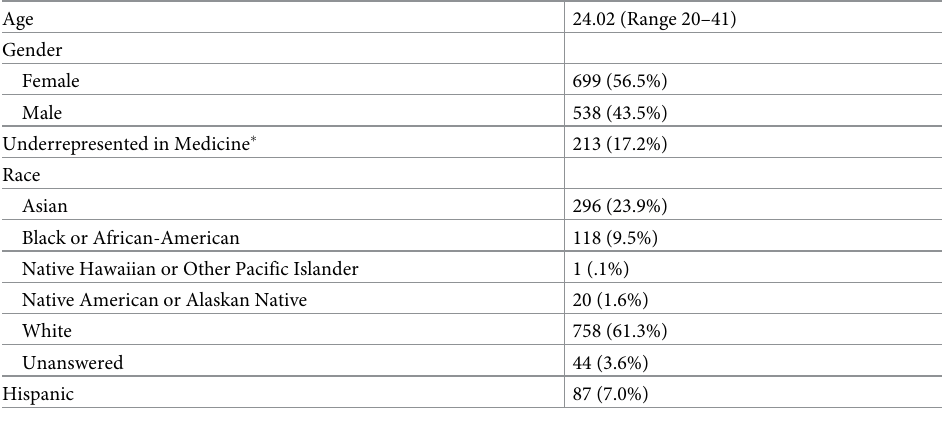
Table 1. Demographic information for applicants.